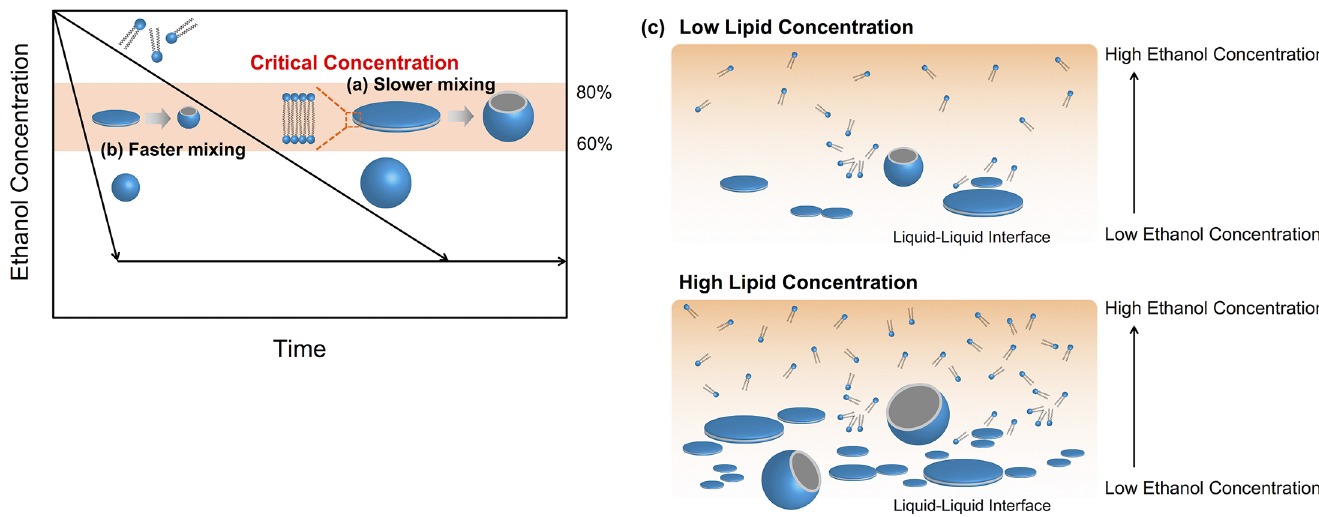
Fig 7. Summary of the LNP formation process in the microfluidic device. LNP formation process in a microfluidicdevice at (a) slower mixing and (b) faster mixing. (c) Schematic illustrationof the LNP formation at the saline-ethanol interface.